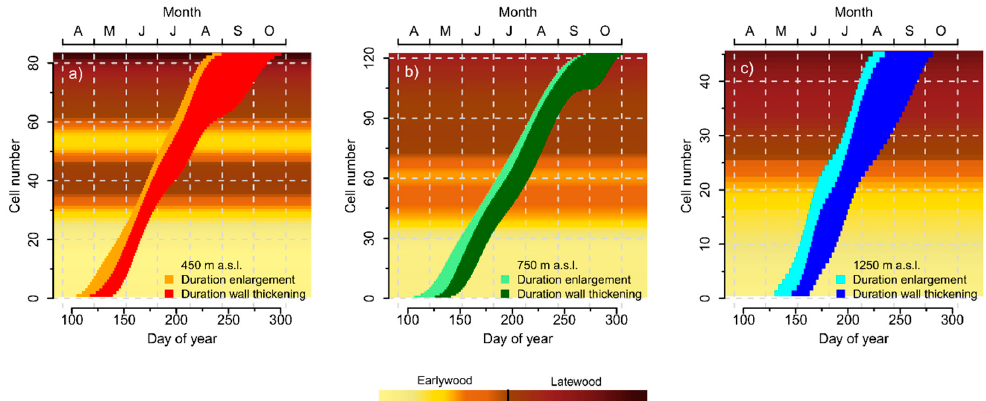
Figure 3. Timings of the individual tracheids in the cell enlargement and secondary wall thickening phase for the ( a ) 450 m, ( b ) 750 m, and ( c ) 1250 m a.s.l. elevation sites, respectively. Background colors reflect its Mork’s Criterion (MC) for each cell, according to earlywood (MC < 1) and latewood (MC ≥ 1) morphology, as defined in Denne [50].